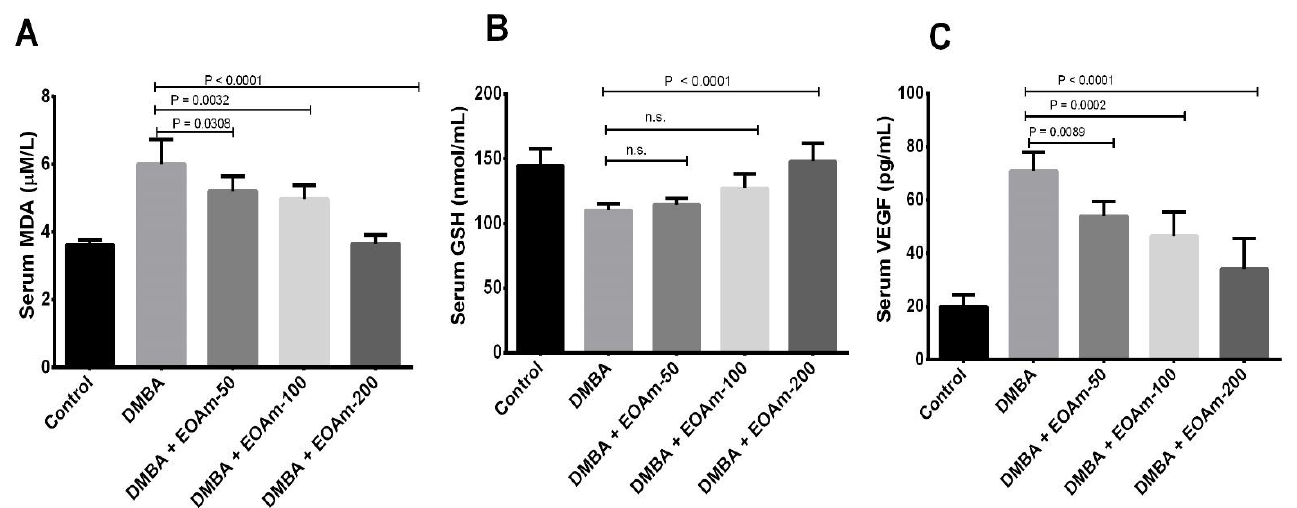
Figure 3. Serum levels of MDA ( A ), GSH ( B ), and VEGF ( C ) in rats treated with A. muricata essential oil (EOAm). Values expressed as mean ± S.D. n.s., non-significant.